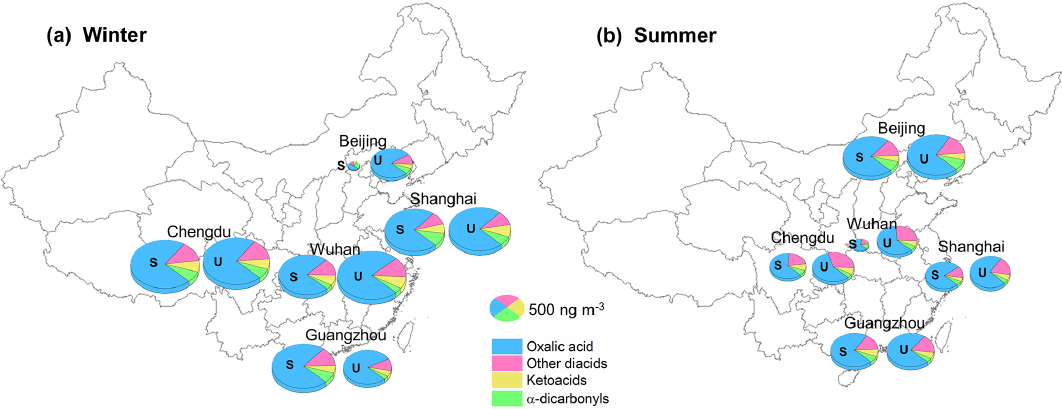
Figure 1. Dicarboxylic acid, oxocarboxylic acid, and α -dicarbonyl concentrations in PM 2 . 5 collected in five Chinese megacities in (a) winter and (b) summer. Samples were collected at a suburban site (S) and an urban site (U) in each city.